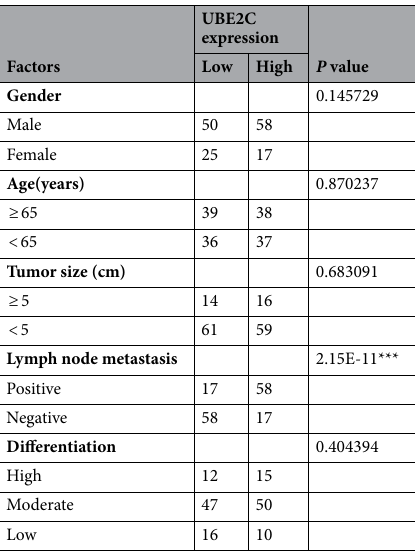
Table 1. Correlation between UBE2C expression and clinicopathological characteristics of 150 patients with the EC. *** P <